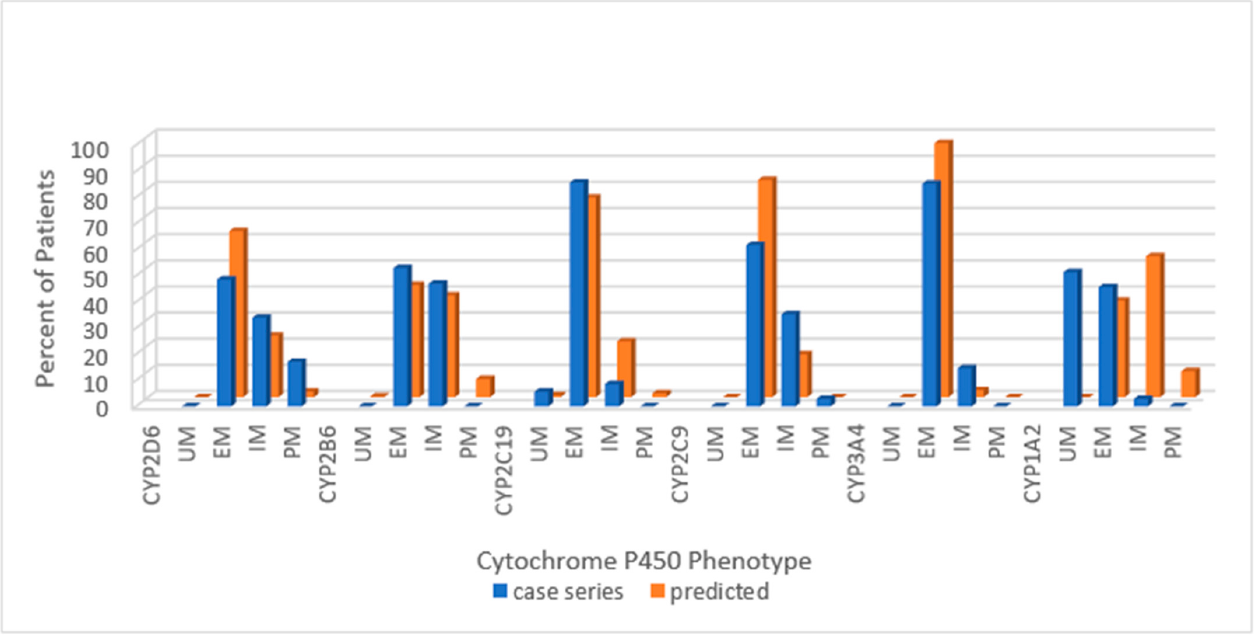
Figure 1. Distribution of Cytochrome P450 phenotypes among the combined PWS cohort ( n = 35) compared to predicted, normative populations [https://www.pharmgkb.org/page/cyp2d6RefMaterials]; [https://www.pharmgkb.org/page/cyp2b6RefMaterials]; [https://www.pharmgkb.org/page/cyp2c19RefMaterials]; [https://www.pharmgkb.org/page/cyp2c9RefMaterials]; [20,27]. Key: